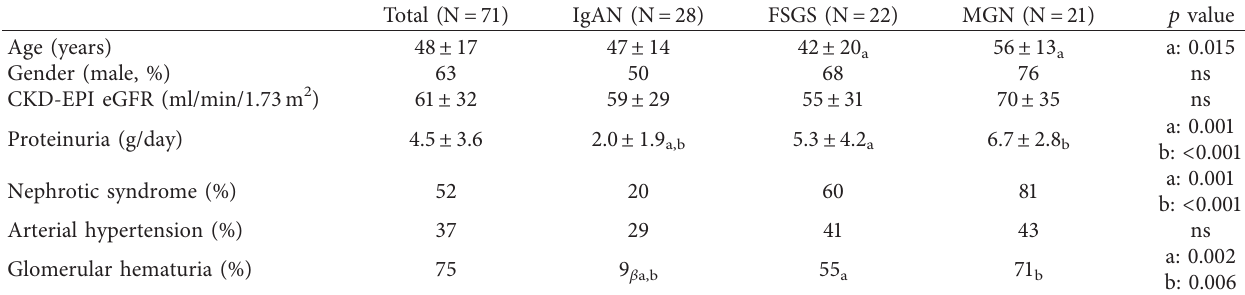
Table 1: Demographic, clinical, and laboratory patient characteristics.